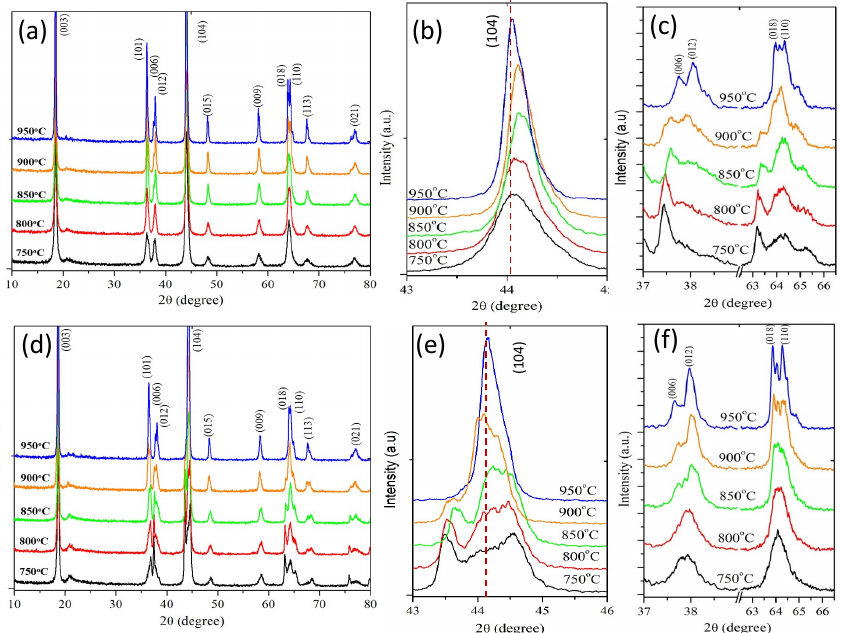
Figure 2. X-Ray pattern of LiNi 0.5 Mn 0.5 O 2 sample prepared ( a ) by sol-gel sample and magnification of angle range ( b ) correspond (104) peak ( c ) splitting peak. ( d ) by solid-state sample and magnification of angle range ( e ) correspond (104) peak and ( f ) splitting peak.